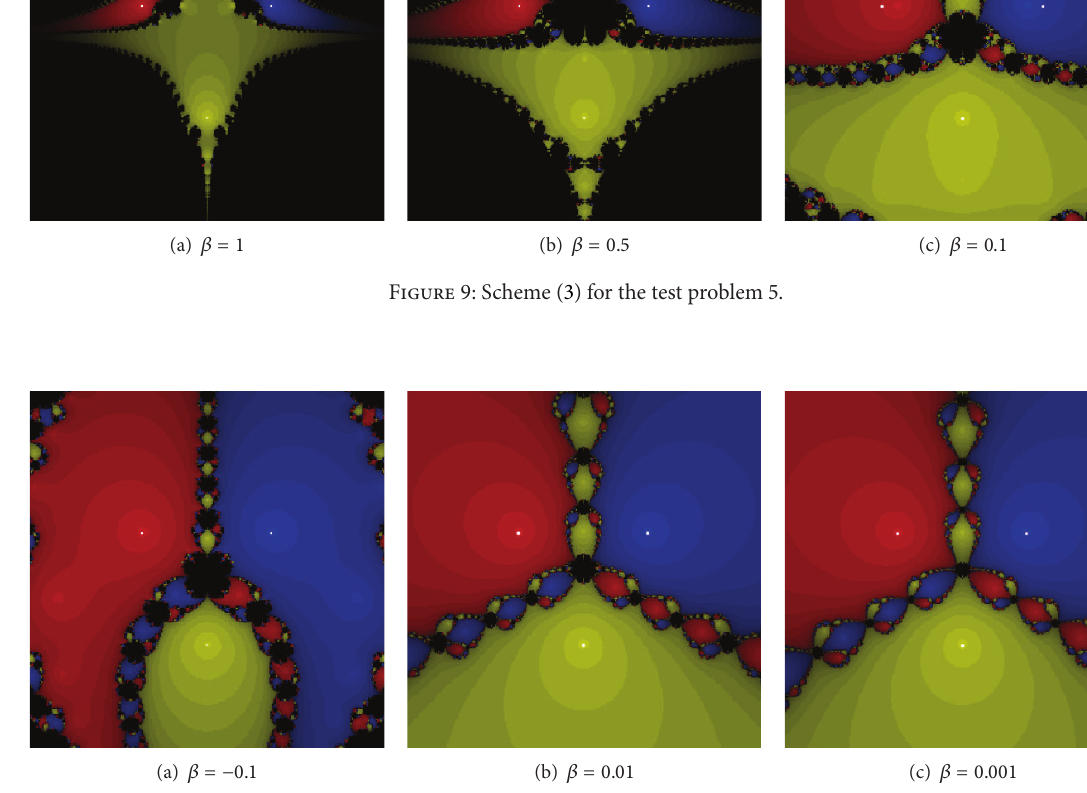
Figure 10: Scheme (3) for the test problem